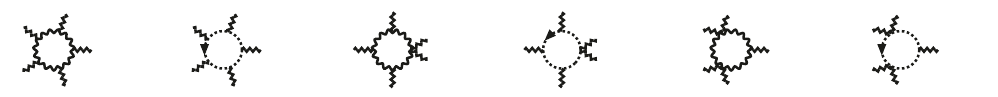
Figure 1 . 1-loop contributions to the 5-point function in the background field gauge. Wiggly lines denote gluons and dotted lines ghosts. The diagrams have been drawn with Axodraw